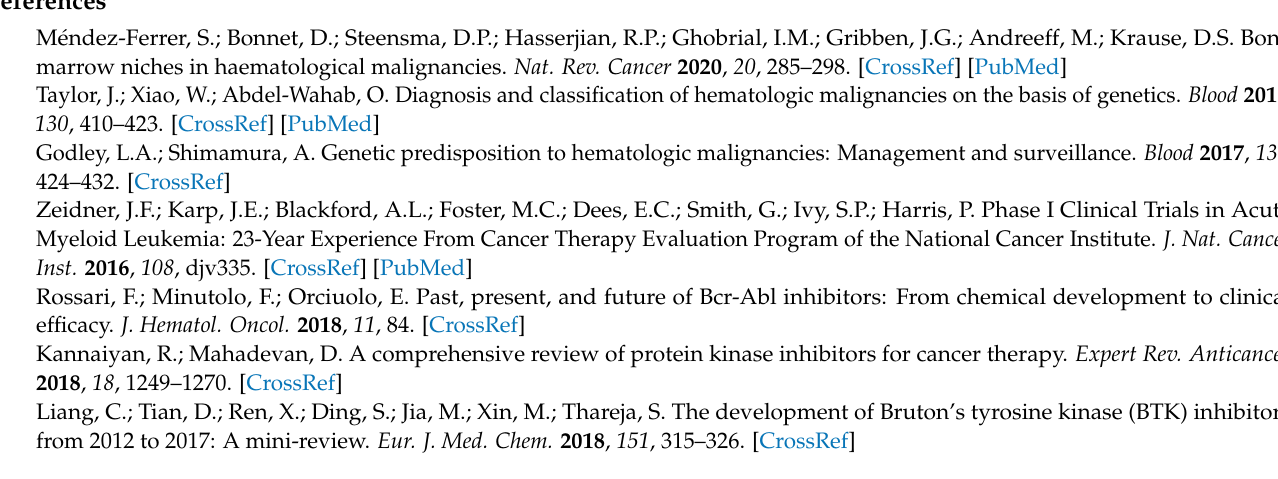
of selected compounds; Table S1: Statistical parameters for CoMFA analysis in Bcr-Abl, BTK and FLT3-ITD; Table S2: Summary of external validation parameters for CoMFA models; Table S3: Experimental and predicted pIC 50 and residual values for analysed compounds according to CoMFA; Figure S1: Plots of experimental pIC 50 versus predicted pIC 50 for CoMFA in Bcr-Abl, BTK and FLT3- ITD; Figure S2: Co-crystallized ligands with their experimentally determined binding mode are shown in green, while the docking pose of the ligands from our self-docking protocol are shown in yellow; Figure S3: Schemes of the essential interactions reproduced by the self-docking poses. The important hydrogen bonds are amino acids M318, M477 and C694 for Abl (A), BTK (B) and FLT3 (C), respectively; Figure S4: Docking protocol for synthetized ligands; Figure S5: Graphic representation of the active site of Bcr-Abl protein, Table S4: The main energetic contributions per residues between the active site of Bcr-Abl with the synthesized ligands; Table S5: Prime MM-GBSA calculation of the docked complexes (ligands-Abl); Figure S6: Graphic representation of the active site of BTK protein; Table S6: Main energetic contributions per residues between the active site of BTK with the synthesized ligands; Table S7: Prime MM-GBSA calculation of the docked complexes (ligands-BTK); Figure S7: Graphic representation of the hydrophobic pocket of BTK protein and 5j structure in yellow; Table S8: The main energetic contributions per residues the hydrophobic pocket of BTK with synthetized ligands; Figure S8: Graphic representation of the active site of FLT3 protein; Table S9: The main energetic contributions per residues between the active site of FLT3 with the synthesized ligands; Table S10: Prime MM-GBSA calculation of the docked complexes